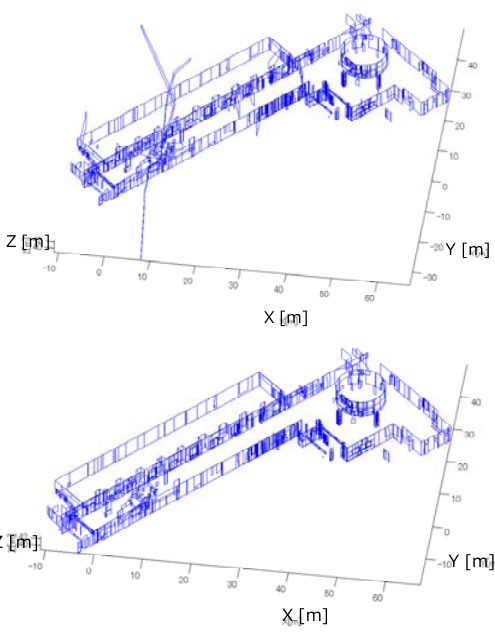
Figure 13. Integrated results in polygon extraction from 64 viewpoints (top image) and the result after manual editing (bottom image)